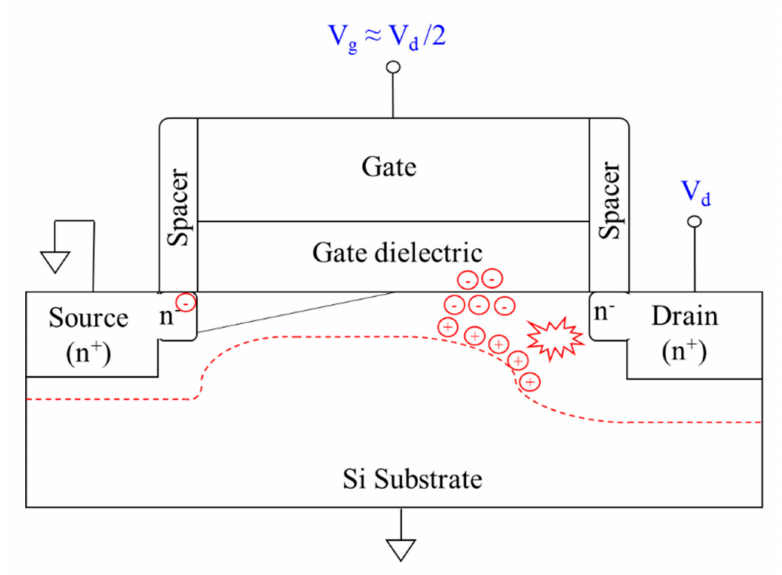
Figure 2. Major mechanism of drain-avalanche-hot-carrier generation.